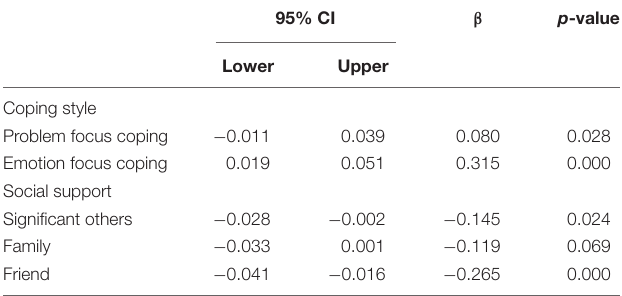
TABLE 2 | Psychological distress, coping strategies, and social support in Jakarta. Hopkins symptoms checklist-25